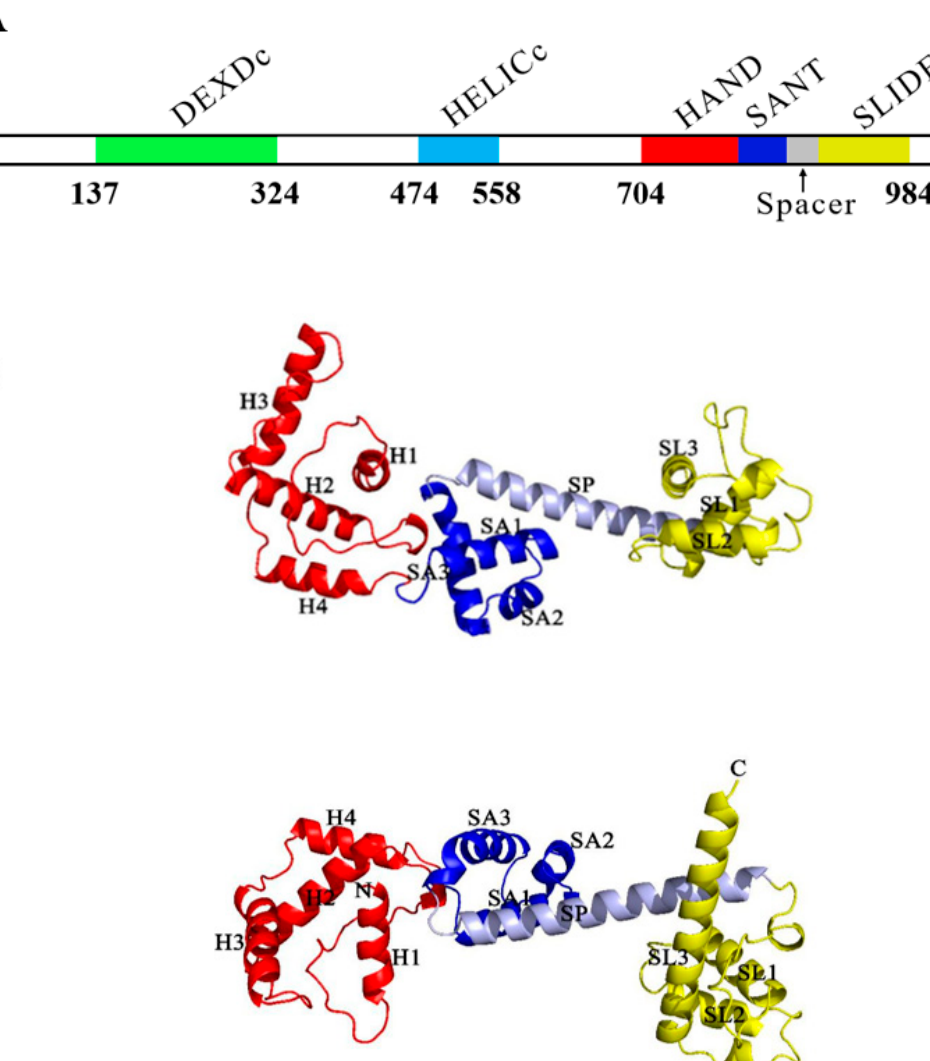
Figure 1. This The full-length cDNA sequence of Bemisia tabaci MEAM1 BtISWI and its deduced amino acid sequence. The full-length cDNA of MEAM1 BtISWI is 3712 bp, and the ORF (233–3301 bp) encodes a polypeptide of 1022 amino acids.